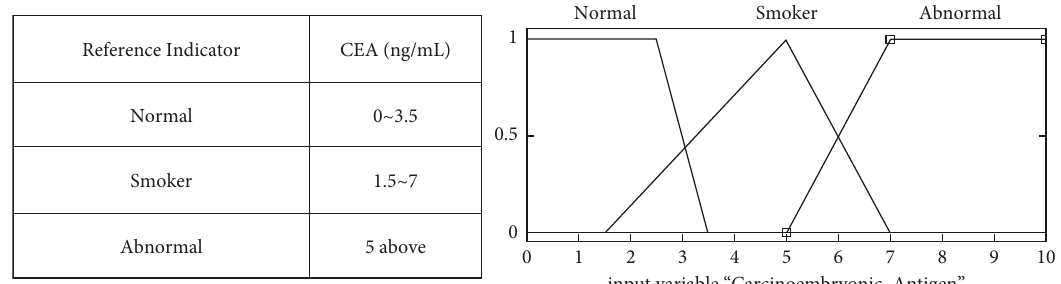
Figure 7: Input attribution function carcinoembryonic antigen,